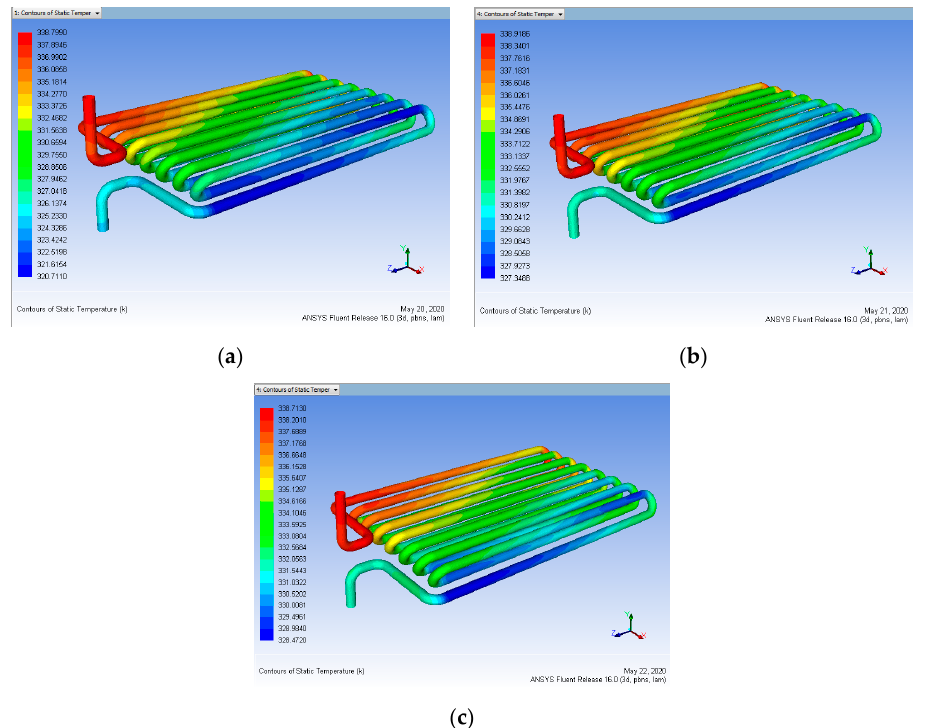
Figure 19. Heat input 343 K vs. Coating Thickness 100 µm for mass flow rate ( a ) 0.15, ( b ) 0.30, ( c ) 0.45 L/min (After Coating). Table 10. CFD Analysis Reading for 343 K.